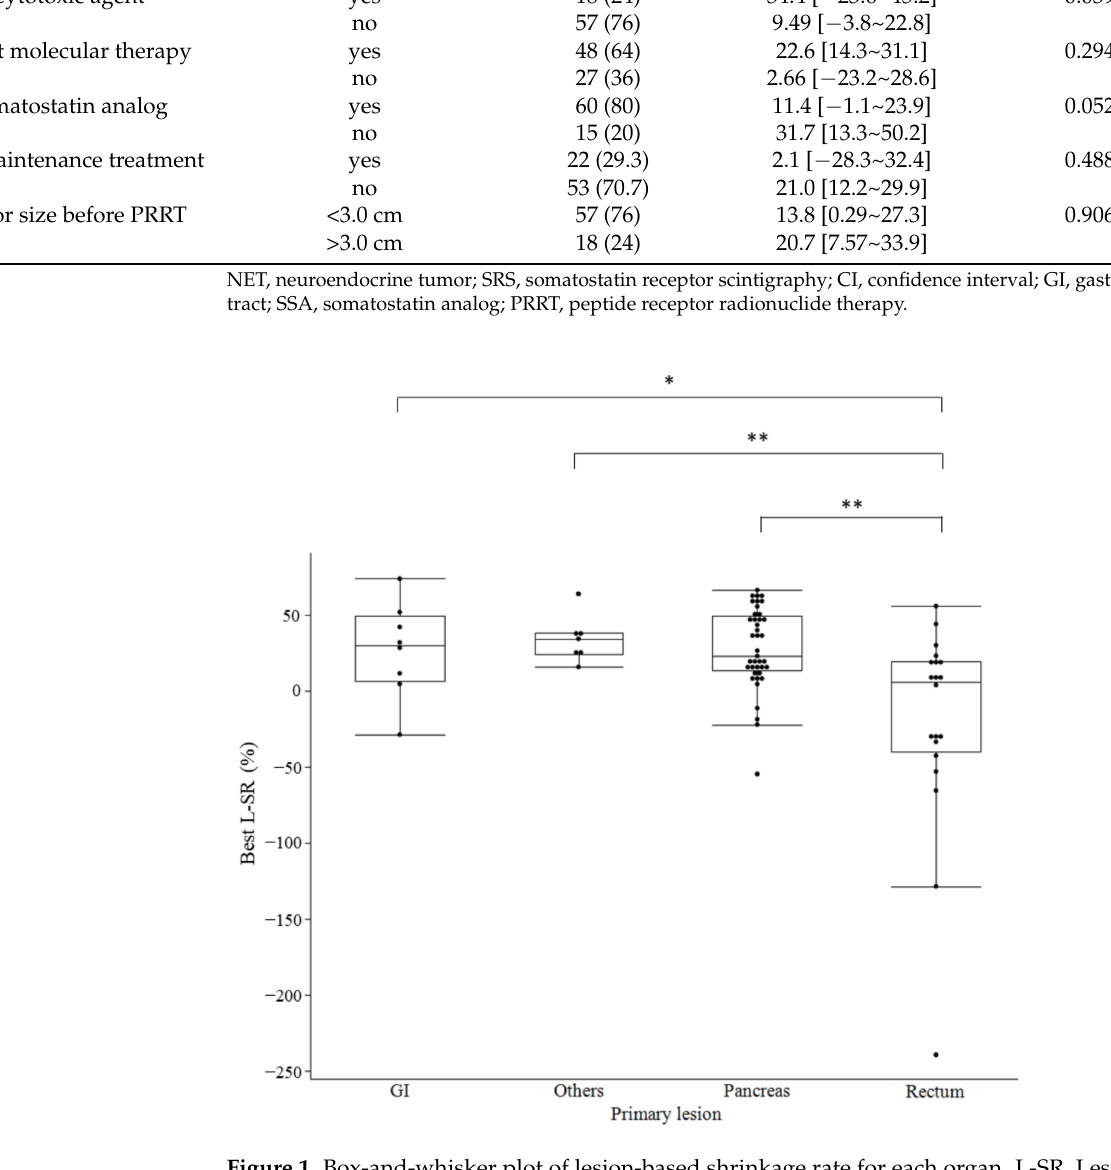
Figure 1. Box-and-whisker plot of lesion-based shrinkage rate for each organ. L-SR, Lesion-based shrinkage rate; GI, gastrointestinal tract; * p < 0.05, ** p < 0.01. In comparisons based on the radionuclides used in the treatment, no